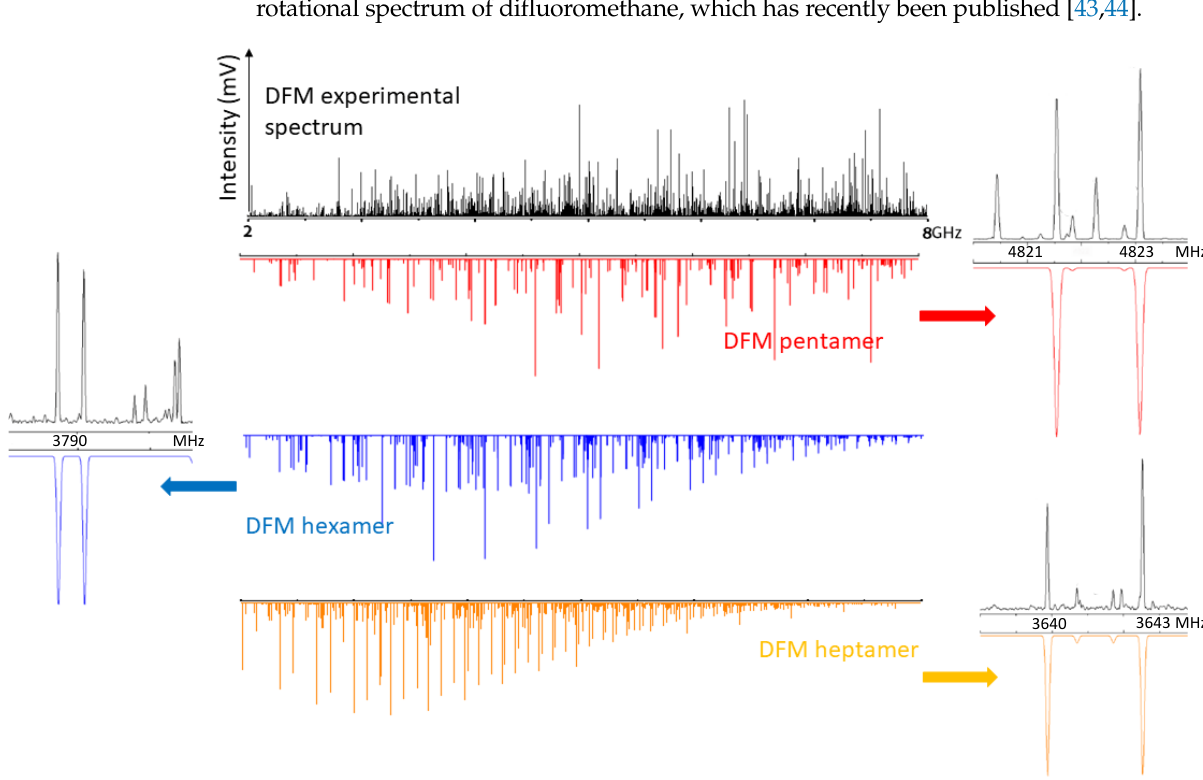
Figure A1. The 2–8 GHz spectrum of difluoromethane (top black), with predictions of three assigned clusters. Specifically, red transitions correspond to difluoromethane pentamer, blue to difluoromethane hexamer, and orange to difluoromethane heptamer. The rotational temperature chosen for the predictions was 2 K, which best reproduces the spectral intensities for the clusters, whilst the relative intensities between the three theoretical spectra are not to